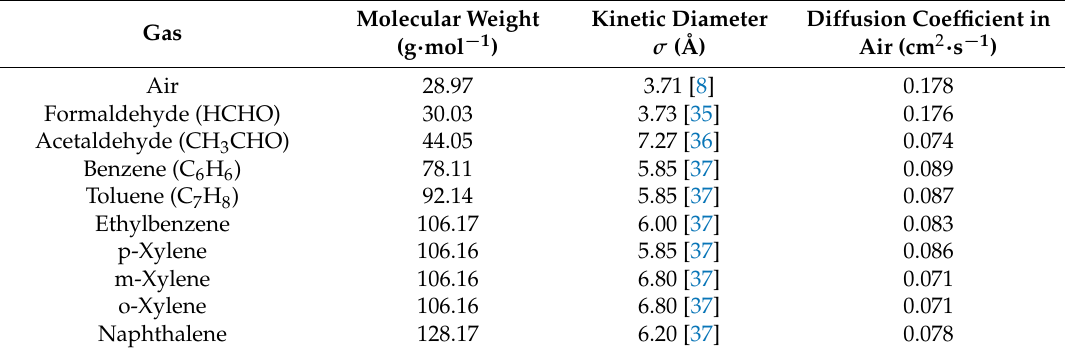
Table 2. Diffusion coefficient of several gases in air at 1 atm and 23 ◦ C.